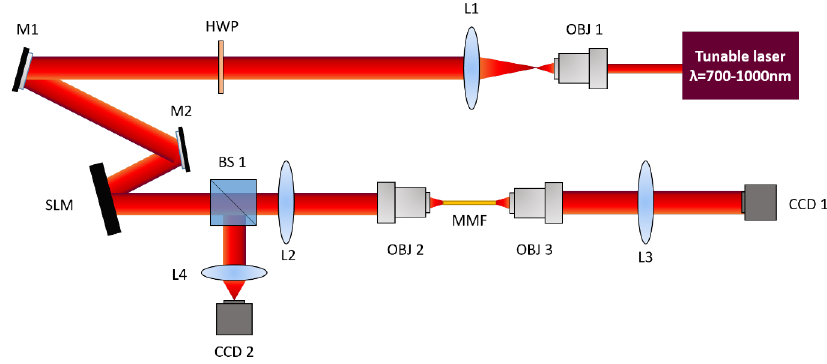
Figure 1. Optical setup for the collection of the image dataset used for training the DNN algorithms. (L = lens, OBJ = microscope objective, HWP = half-wave plate, M = mirror, BS = beam splitter).